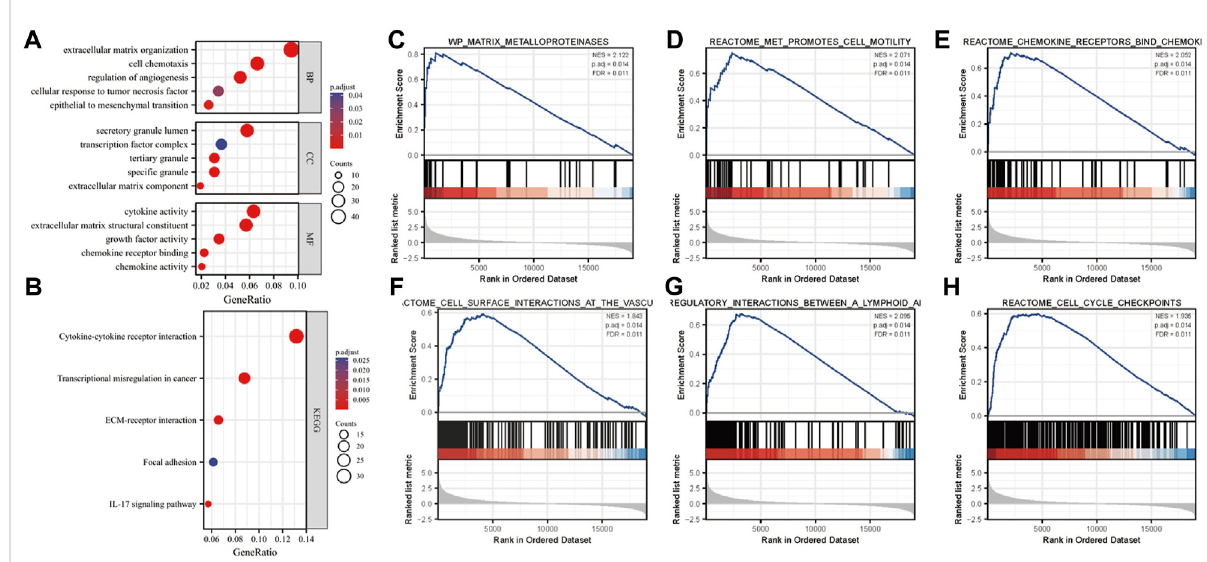
FIGURE 3 AnalysisoftheroleofMFAP2inglioma. (A) AnalysisoftheGOresults. (B) AnalysisoftheKEGGsignalingpathwaysinvolvingtheMFAP2proteinin glioma. (C – H) Enrichment plots from GSEA.